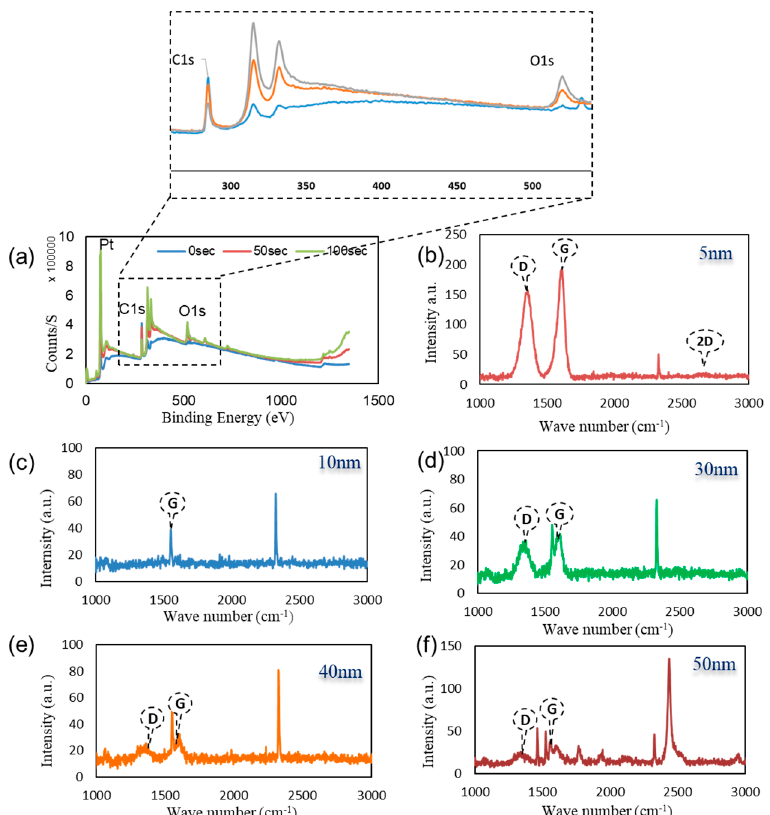
Figure 2. ( a ) XPS survey spectra on the surface of the graphene film after 0 s, 50 s, and 100 s etching of the surface. RAMAN spectra of graphene layers on top of different Pt thicknesses ( b ) 5; ( c ) 10; ( d ) 30; ( e ) 40; ( f ) 50 nm film.